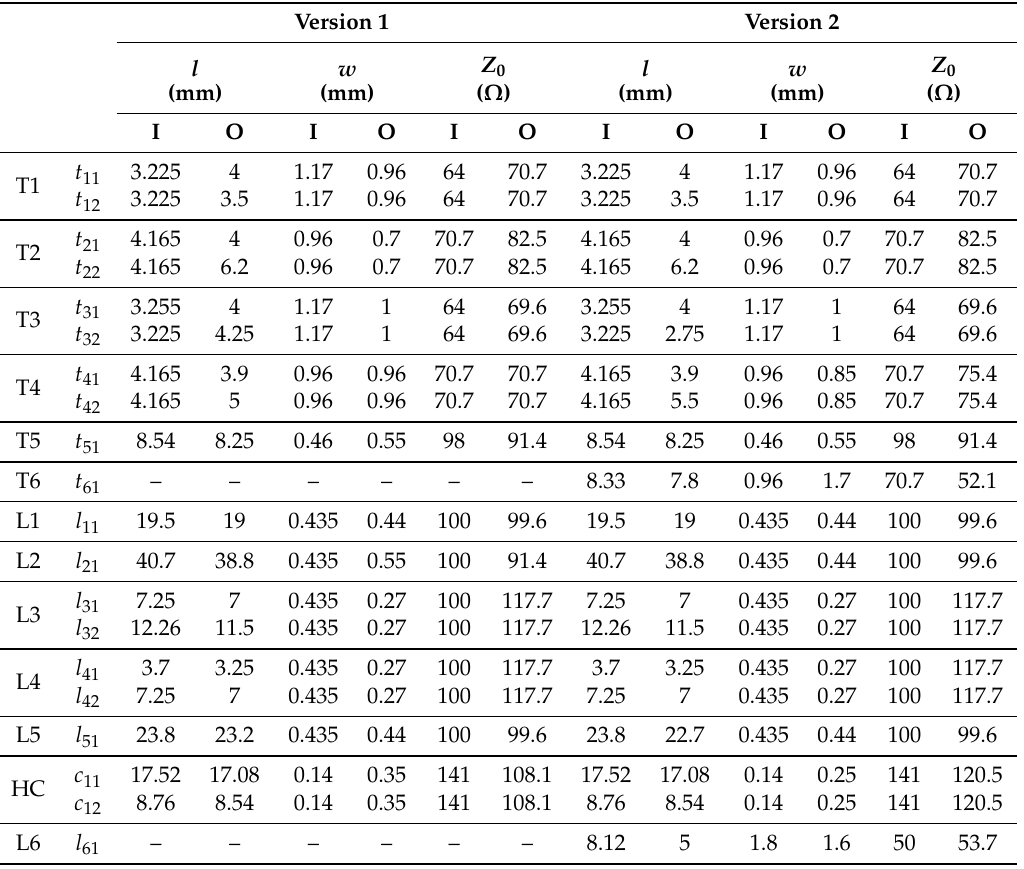
Table 2. Initial (I) and optimised (O) parameters of FN microstrip lines for version 1 and version